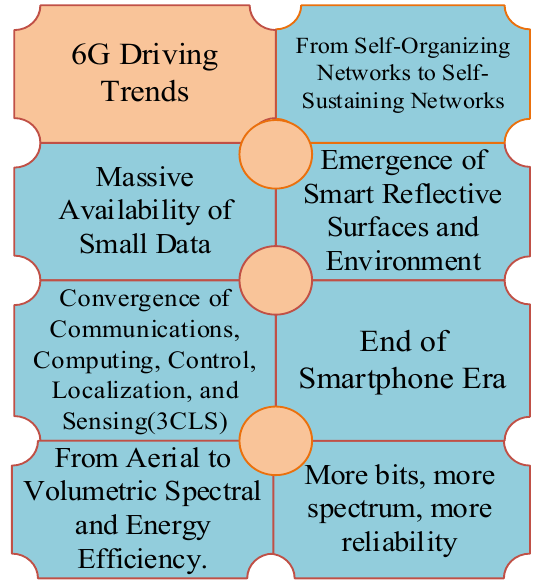
Figure 3. 6G Driving Trends.